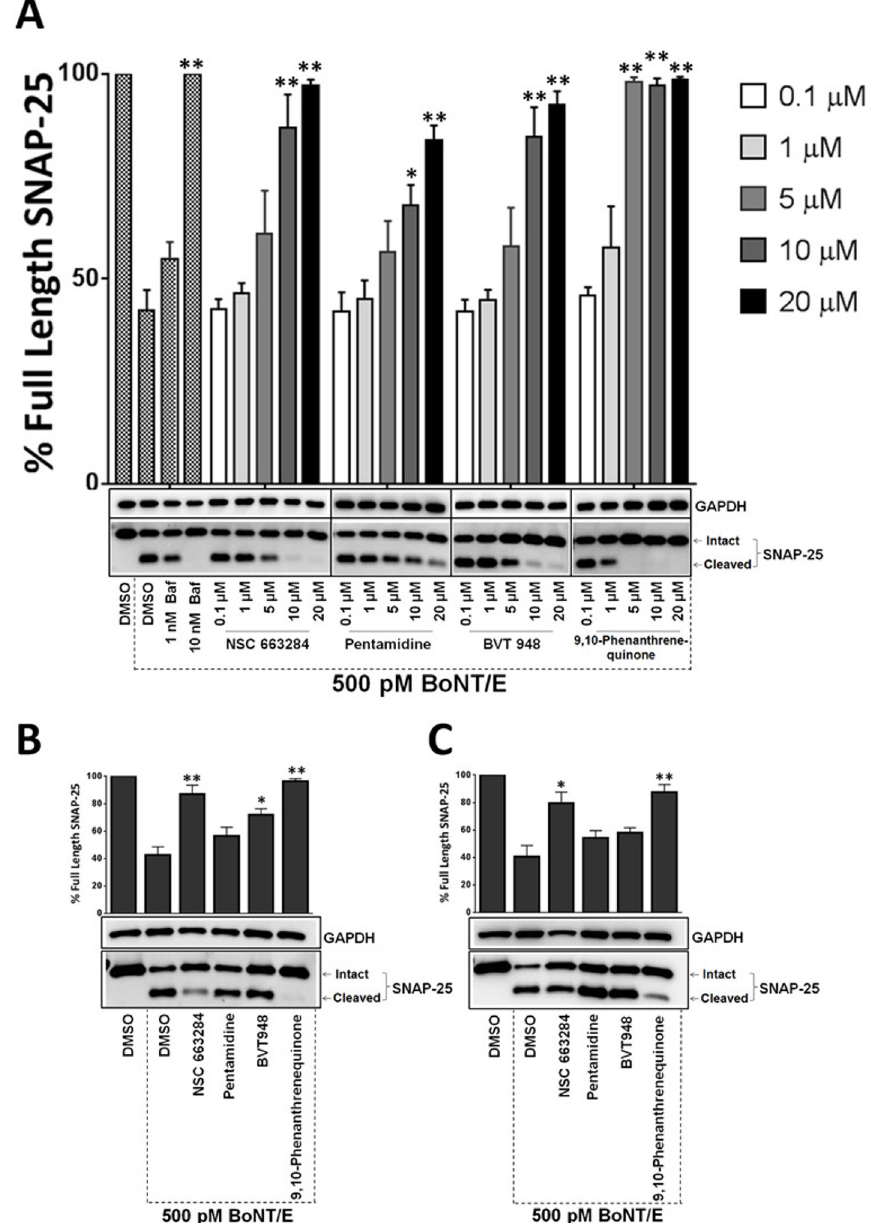
and analyzed by Western blotting. The compounds inhibit BoNT/E in a post-exposure human neuron model (B and C, similar to Figs 3 and 4). Compounds (20 μ M) were added either 30 min (B) or 60 min (C) after BoNT/ E (500 pM) intoxication. The values are presented as mean ± SEM from at least three independent experiments. $$ , $ Value significant at 99% and 95% confidence level, respectively, compared to DMSO +Toxin control conditions (Student ’ s t-